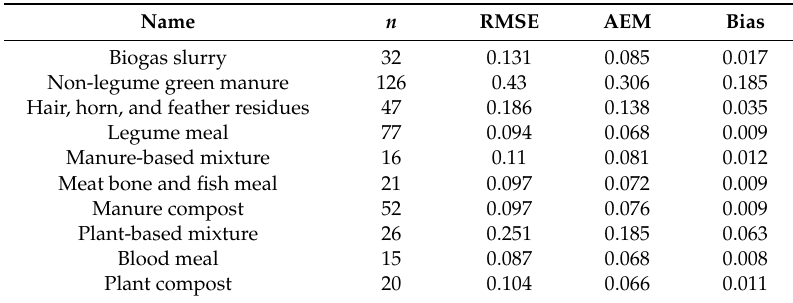
Table 5. Model statistics of the prediction quality of the observed data. Root mean squared